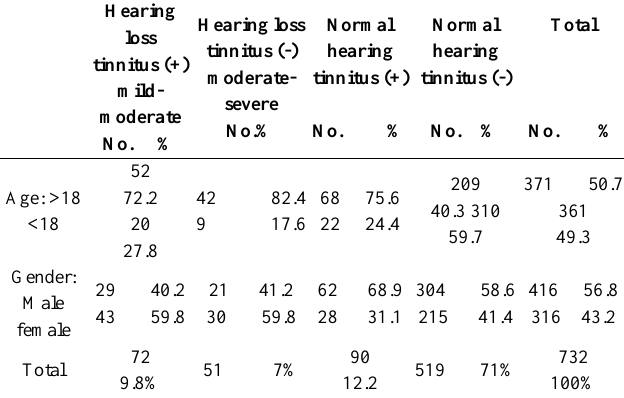
Table 2 : the distribution of patients by type of hearing level, age and gender